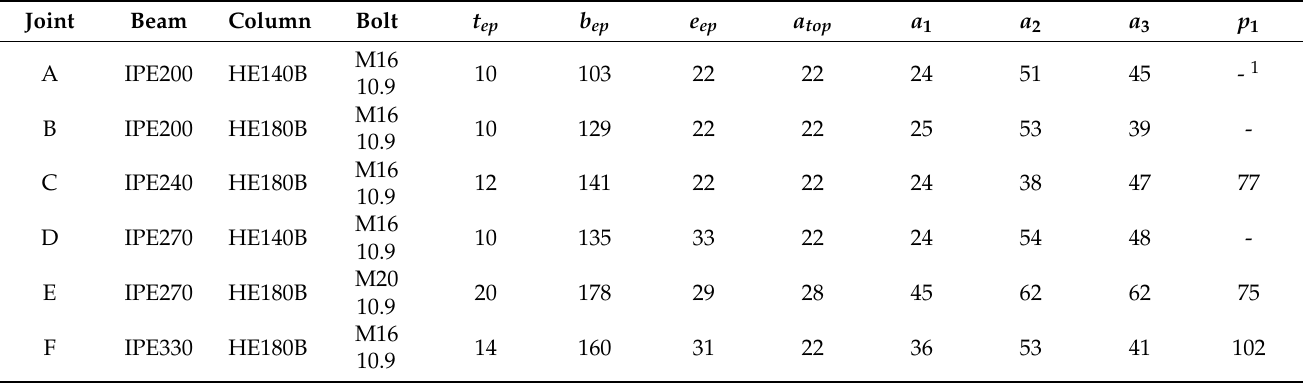
Table 9. Frame B: Final joint details (size in